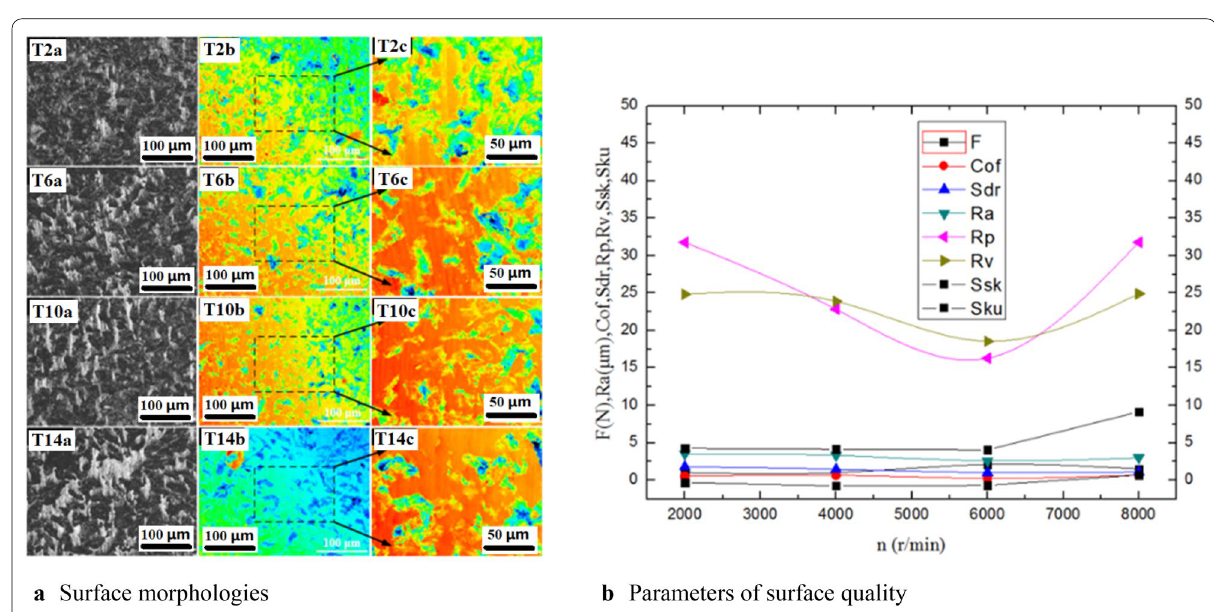
Figure 3 Experimental results of group